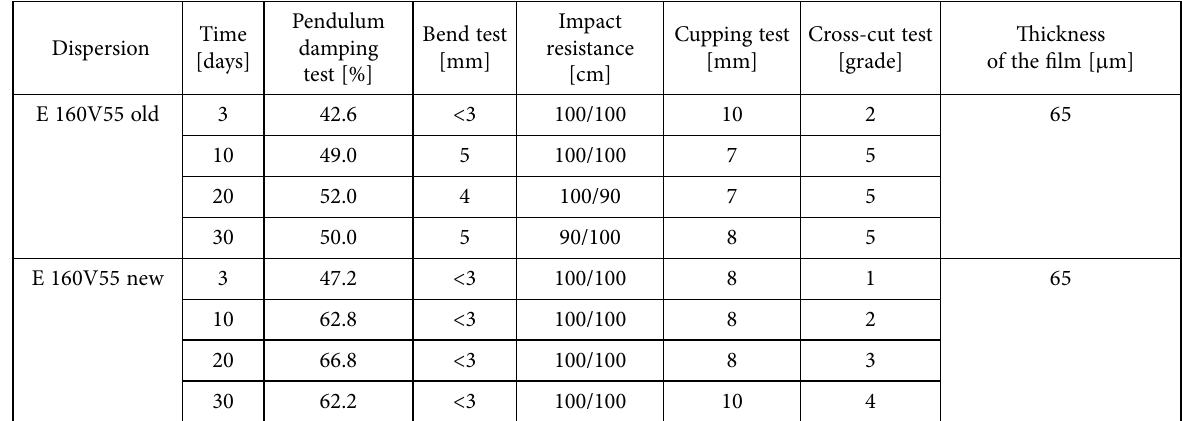
Table 3. Properties of paint films